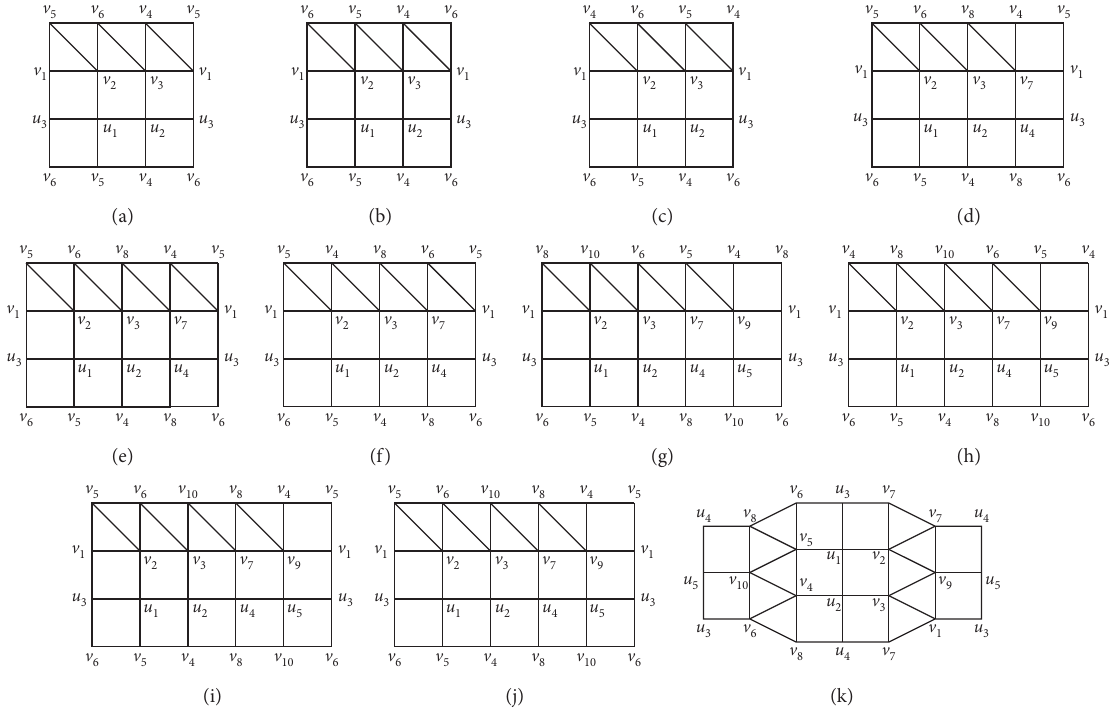
Figure 8: Doubly semiequivelar maps of type [ 3 3 , 4 2 : 4 4 ]